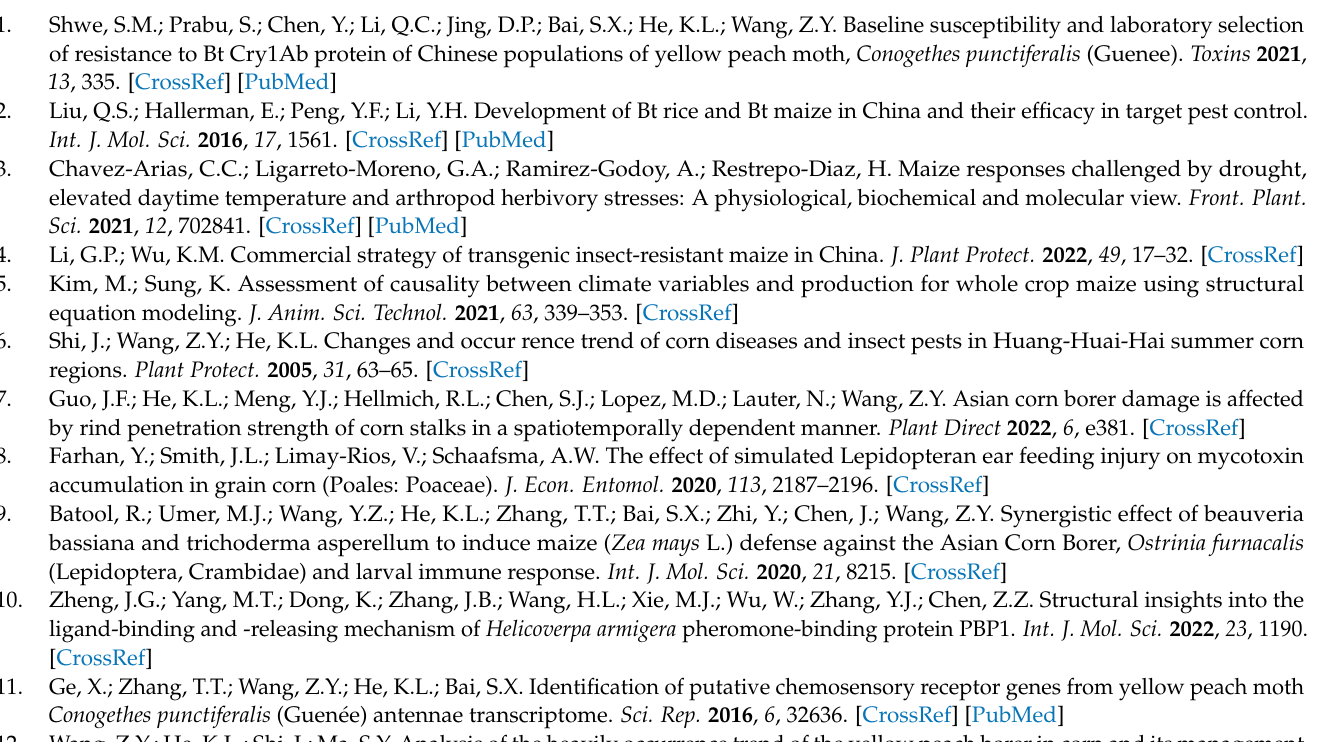
samples; Figure S2: Venn diagram at OTU level; Figure S3: Circos (A) and distance heatmap (B) based on phylum level; Figure S4: Circos (A) and distance heatmap (B) based on family level; Figure S5: Pie chart of the intestinal and corn microbial community at phylum level; Figure S6: Pie chart of the intestinal and corn microbial community at family level; Figure S7: Pie chart of the intestinal and corn microbial community at genus level; Figure S8: Pie chart of the intestinal and corn microbial community at OTU level; Figure S9: Significance difference test based on Kruskal-Wallis rank sum test method at family level (A), genus level (B) and OTU level (C); Figure S10: Linear discriminant analysis (LDA) of three pests; Figure S11: Clustering analysis based on Bray-Curtis distance algorithm at genus level; Figure S12: Co-occurrence network diagram of all samples at phylum level (A), family level (B), genus level (C) and OTU level (D); Figure S13: Pathway heatmap of Level2; Table S1: Summary of multistage annotation information for three insect samples; Table S2: Summary of multi-level annotation information of corn